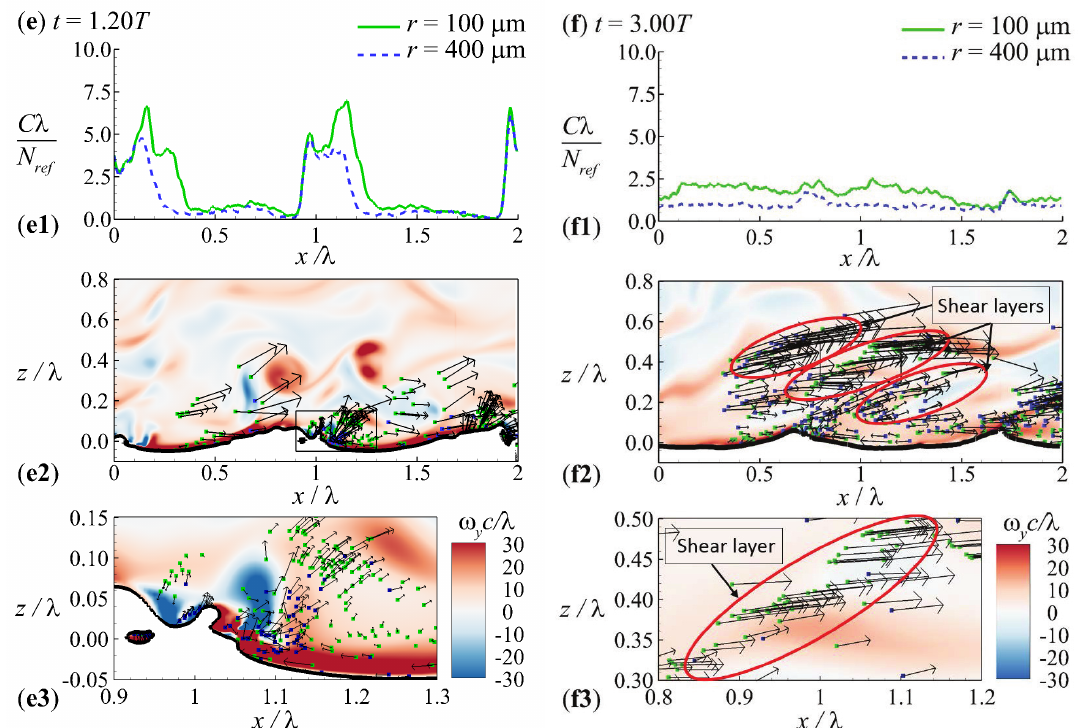
Figure 3. Instantaneous distribution of droplets in Case A55 at ( a ) t = 0.54 T , ( b ) t = 0.70 T , ( c ) t = 0.90 T , ( d ) t = 1.04 T , ( e ) t = 1.20 T , and ( f ) t = 3.00 T . The upper panels of each figure show the streamwise profile of the droplet concentration C λ / N ref . The middle panels show the projected positions of droplets in a spanwise plane. Green and blue dots denote droplets of r = 100 µm and 400 µm, respectively. Only 10% of the droplets are shown in the figure for clearer visualization. The vectors represent the in-plane relative velocity with respect to the wave phase speed c . Contours of the instantaneous spanwise vorticity of the airflow in the plane y = 0 are superimposed. The thick solid lines represent the instantaneous air–water interface in the same plane. The lower panels show the zoom-in view of the region denoted by the box in the middle panel, and only 50% of the droplets are demonstrated for clearer visualization. The wave propagates in the + x